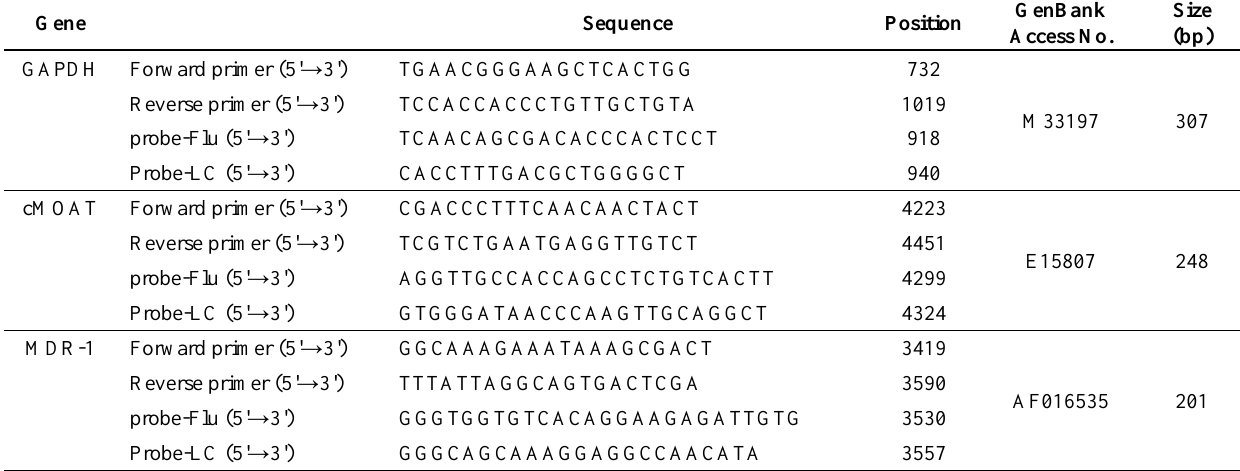
Table 2. The primers and probe sequences for GAPDH and the drug resistance